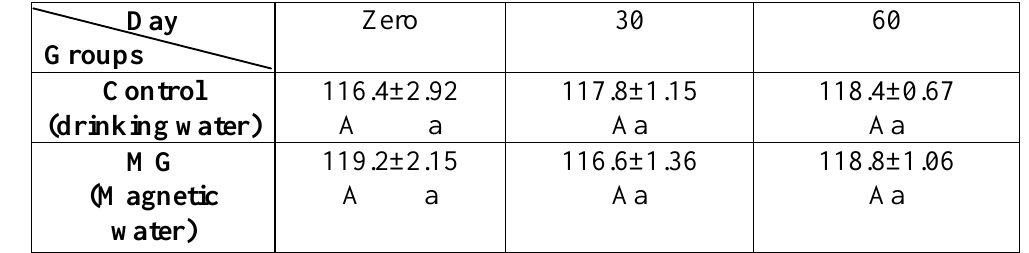
Table (3): Effect of exposure to magnetized water for 60 days on total serum cholesterol (TC) concentration (mg\dl) of adult male